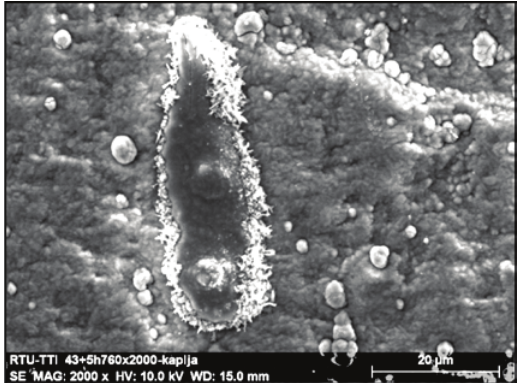
fig. 4. Coating defects as a result of a large drop (× 5,000)